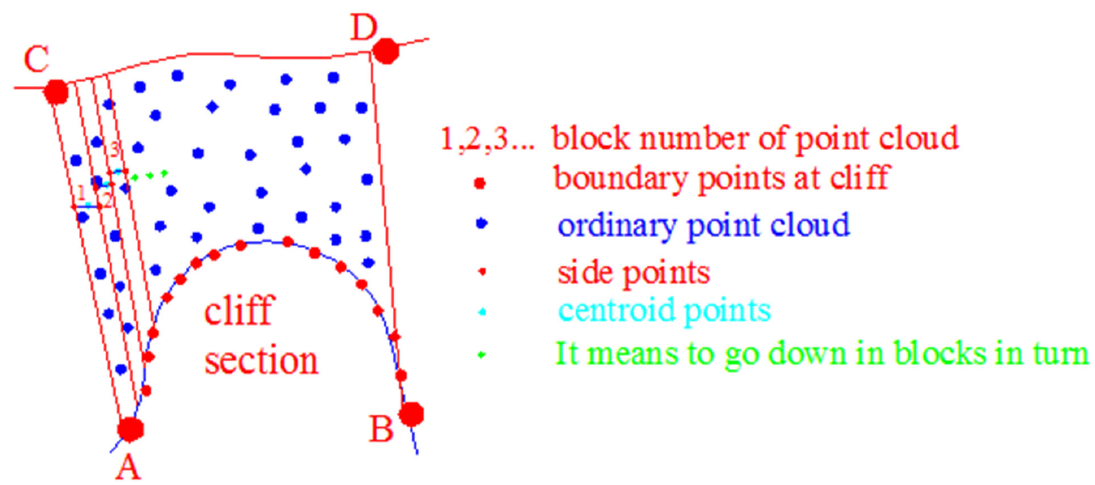
Figure 4. The schematic diagram of point cloud segmentation, centroid points, and side points.